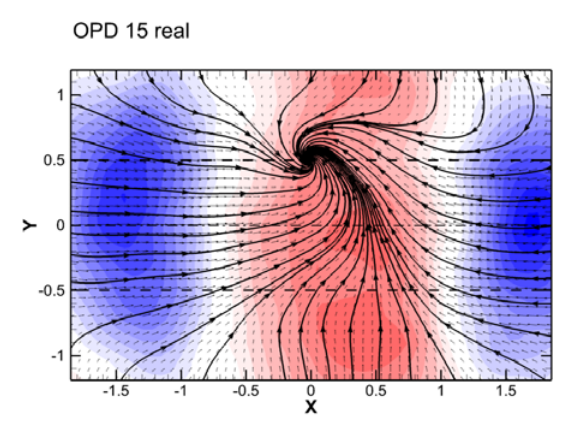
Fig. 12. Real part of the OPD mode 9 topology .